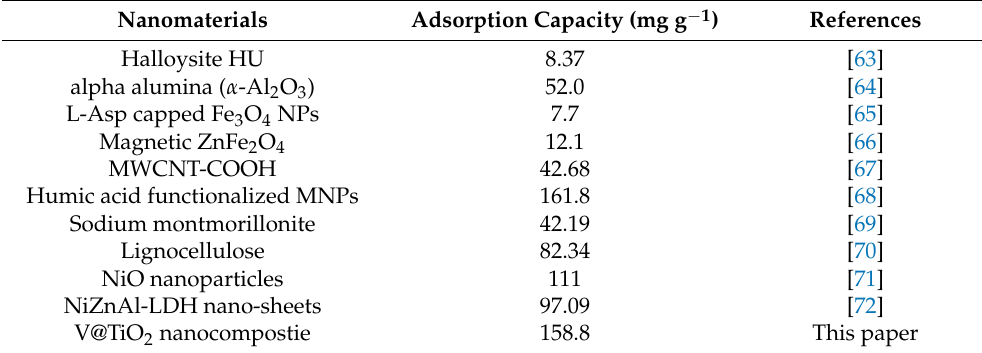
Figure 8. The ( a ) LIM and ( b ) FIM investigations for the adsorption of Rh-B on the synthesized Table 2. Removal parameters of the V@TiO 2 sorbent compared with the diverse Rh-B dye adsorbent nanomaterials.